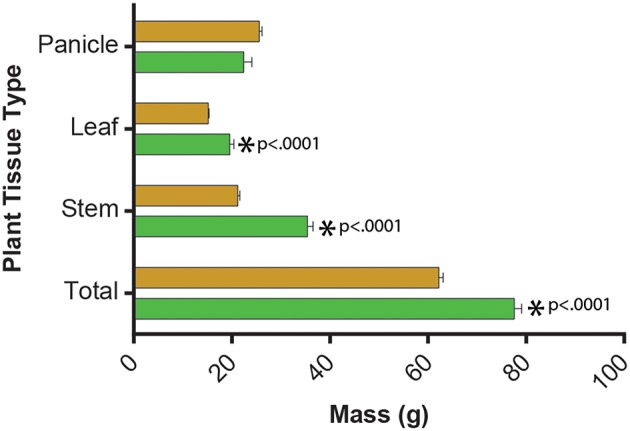
Histogram of dry biomass according to “biomass” vs. grain types of sorghum. Grain types are shown in brown, “biomass” types in green. p-values are from ANOVA by type as referenced in “Materials and Methods.”